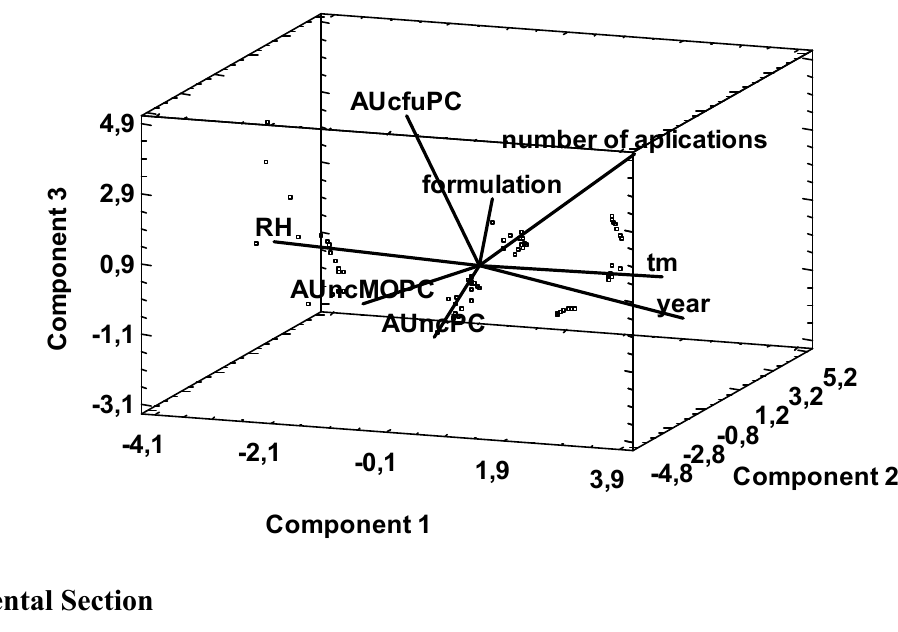
Figure 4. Principal component analysis to the number of Monilinia spp. (AUncMOPC), the number of E. nigrum and P. frequentans conidia and cfu (AUncPC and AUcfuPC) on nectarine and peach surfaces, the number of applications, the year of application, the formulation type, the mean temperature (tm), and the relative humidity (RH). The first three components accounted for 41.3%, 23.5%, and 12.9% of the total variance,